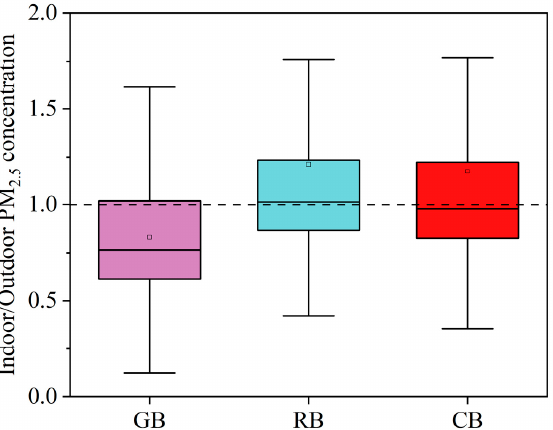
Figure 5. Comparison of indoor/outdoor PM 2.5 concentrations in the GB, RB, and